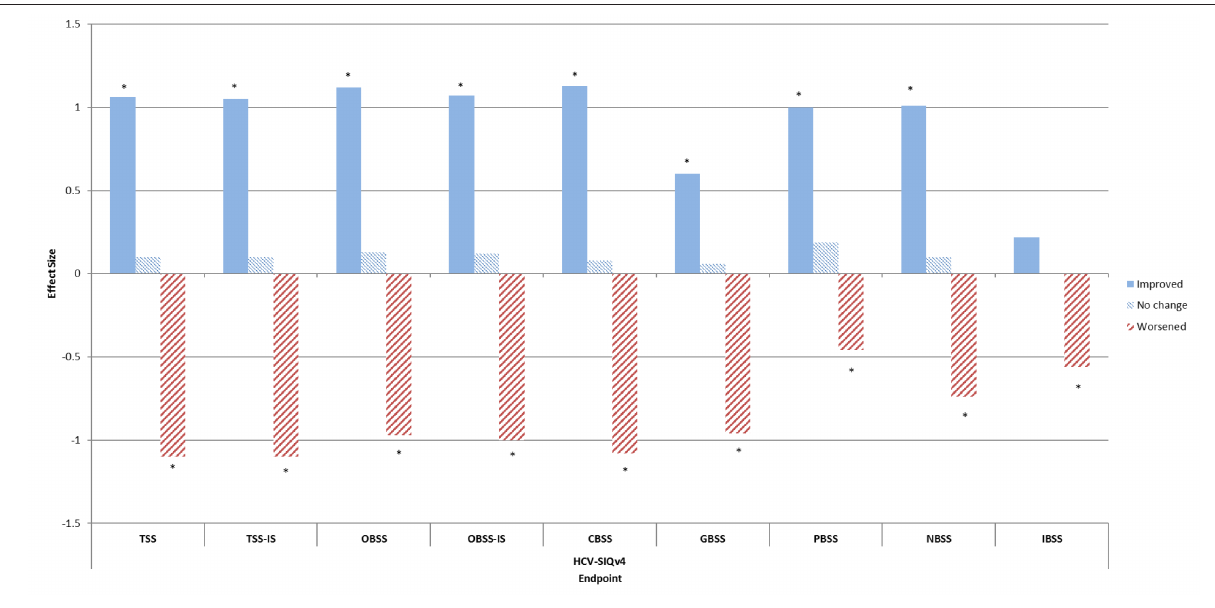
Figure 1. Responsiveness of HCV-SIQv4 Scores from Baseline to Last Study Visit, by Change in Health Limitations over this